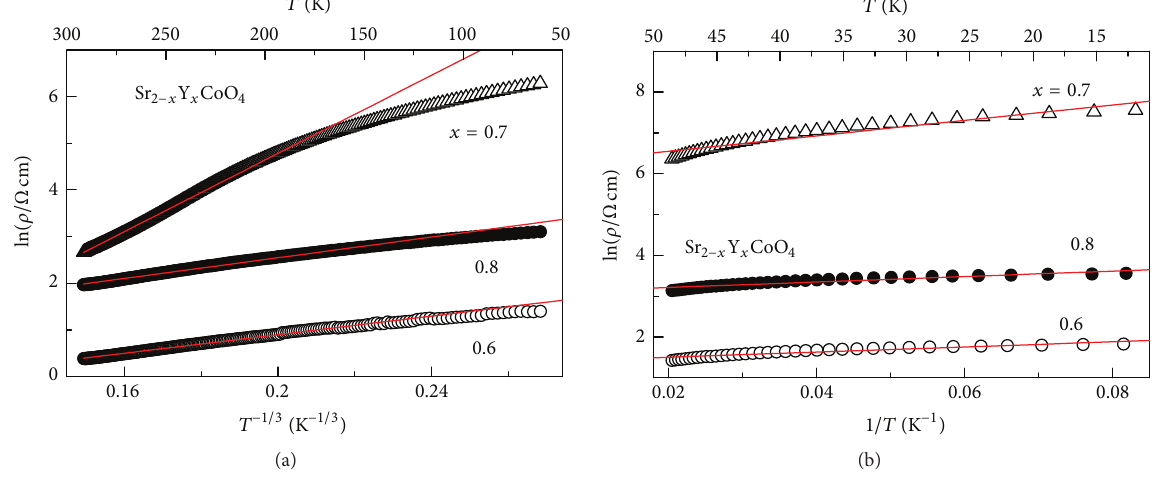
Figure 6: (a) The variation of ln( 𝜌 ) versus 𝑇 −1/3 for Sr 2−𝑥 Y 𝑥 CoO 4 , 𝑥 = 0.60 , 0.70 and 0.80. The solid red lines represent the fitting of the resistivity at 50 K < 𝑇 ≤ 300 K according to 2D-VRH model. The top layer shows shows the corresponding 𝑇 range to 𝑇 −1/3 . (b) The variation of ln( 𝜌 ) against 1/𝑇 for the same selected samples of Sr 2−𝑥 Y 𝑥 CoO 4 . The solid red lines display the fitting according to Arrhenius law and the top layer shows the corresponding 𝑇 range to 𝑇 −1